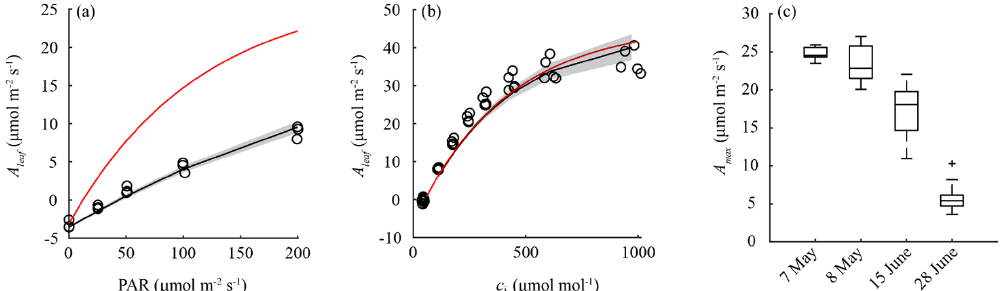
Figure 5. Measurements of leaf-level photosynthesis ( A leaf ) as a function of photosynthetically active radiation (PAR) (a) and leaf interior CO 2 concentrations ( c i ) (b) . These results were used to parameterize the A - g s model for IOP1, as indicated by the black line and shaded 1SD confidence interval. The red line indicates the model response using the default parameter values. (c) Observed and modelled seasonal decline in maximum light-saturated photosynthesis ( A max ). Boxes indicate the variability in observed values in A max ; red markers indicate the modelled net photosynthesis rate using fitted values for A m , max298 . Fitted and default A - g s model parameter values are indicated in Table 3.